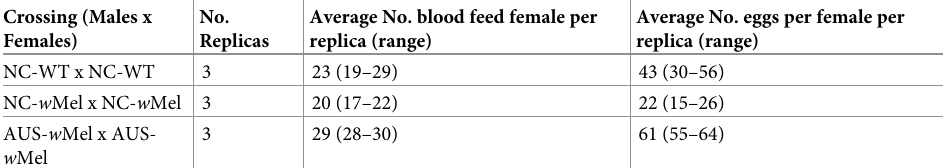
Table 5. Average number of eggs laid per female per